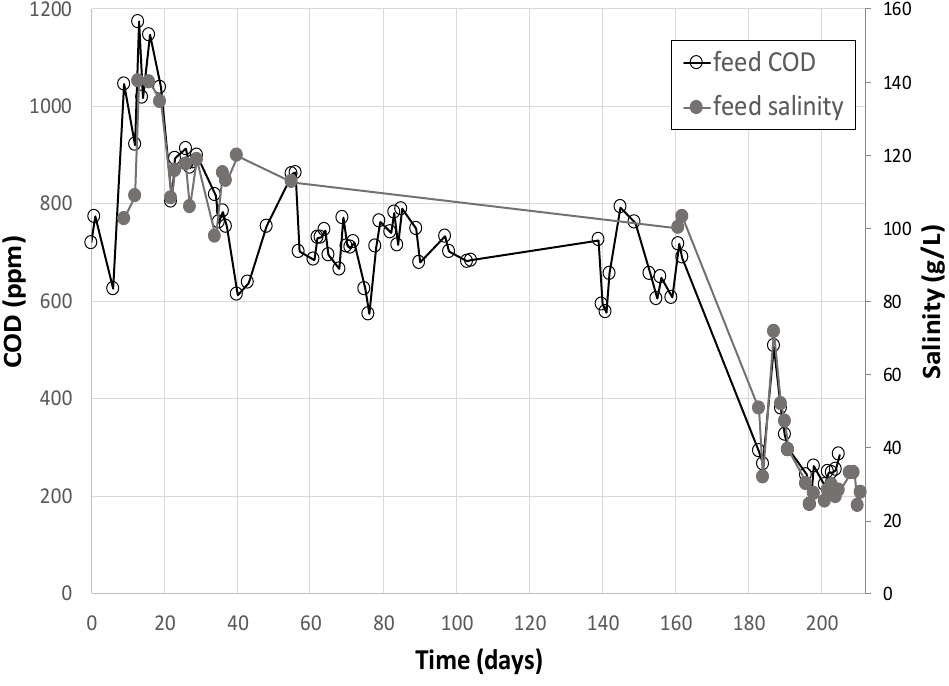
Figure 6. Feed salinity and soluble COD variation during the entire test period.